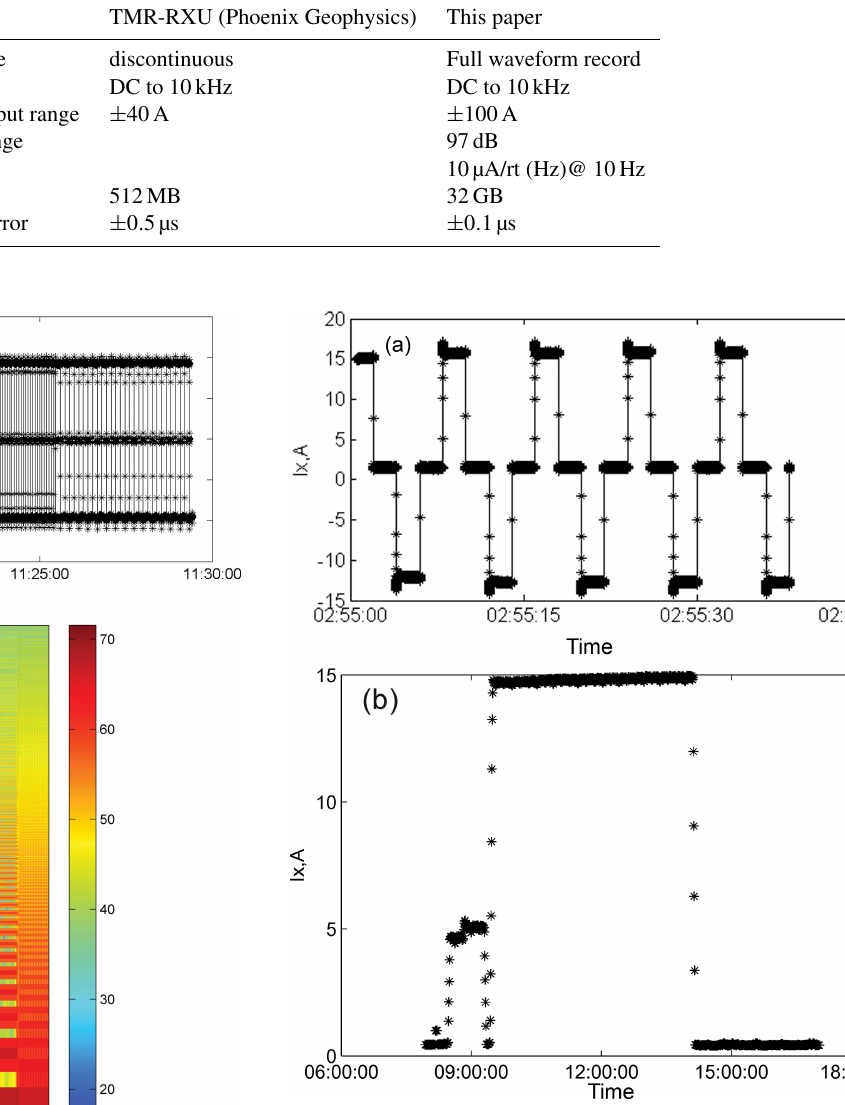
Figure 9. (a) Current time series and (b) long time amplitude vari- able (TDIP